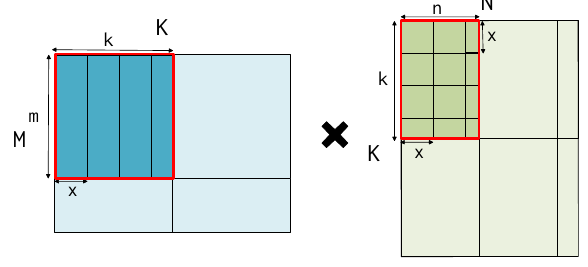
Figure 5. Mapping inside the